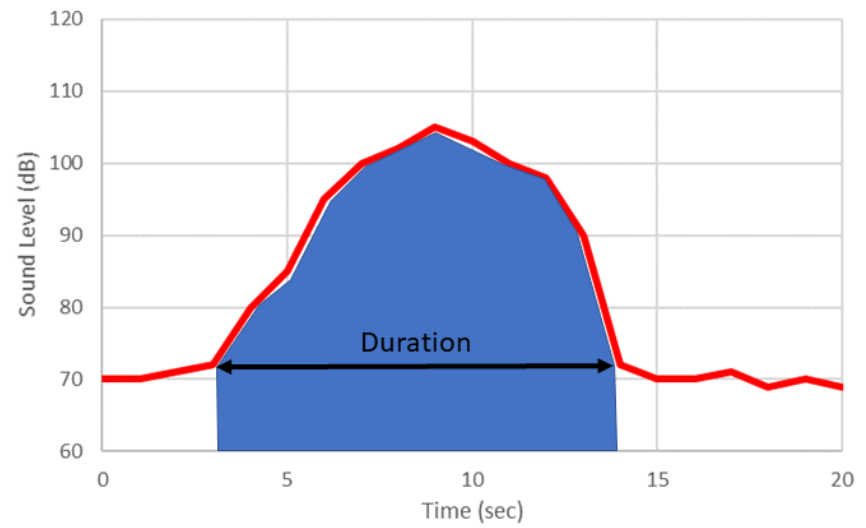
Figure 6. Sound Exposure Level (SEL) calculation procedure from the Overall Sound Pressure Level (OASPL) time